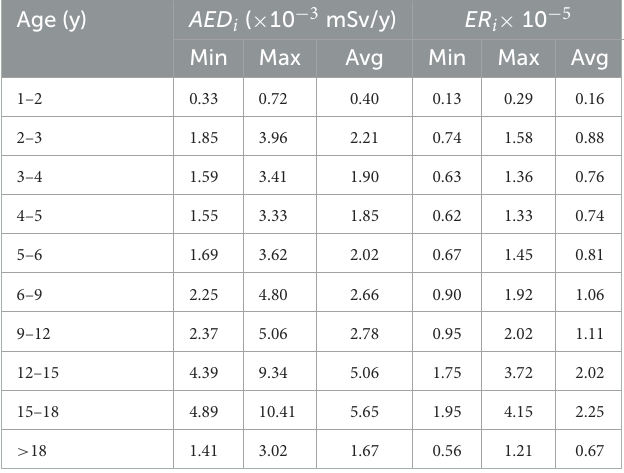
TABLE 7 Statistical analysis for comparison of CAD before and after the operation of SNPP.